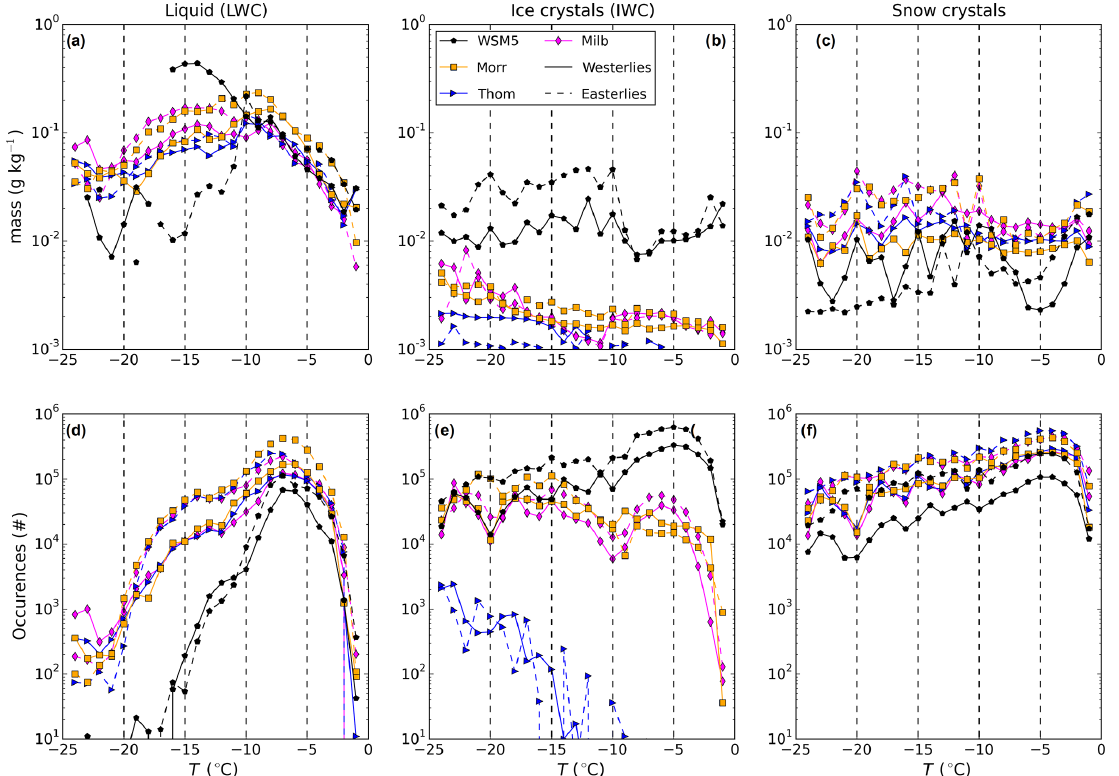
Figure 12. Distribution of (a) LWC, (b) IWC, and (c) snow crystal mass as a function of temperature (per 1 ◦ C bin), and the corresponding distribution of non-null occurrences of LWC, ice, and snow ( d , e , f , respectively) used to derive those mass distributions for the transects shown in Fig. 5 for westerly (solid line) and easterly wind